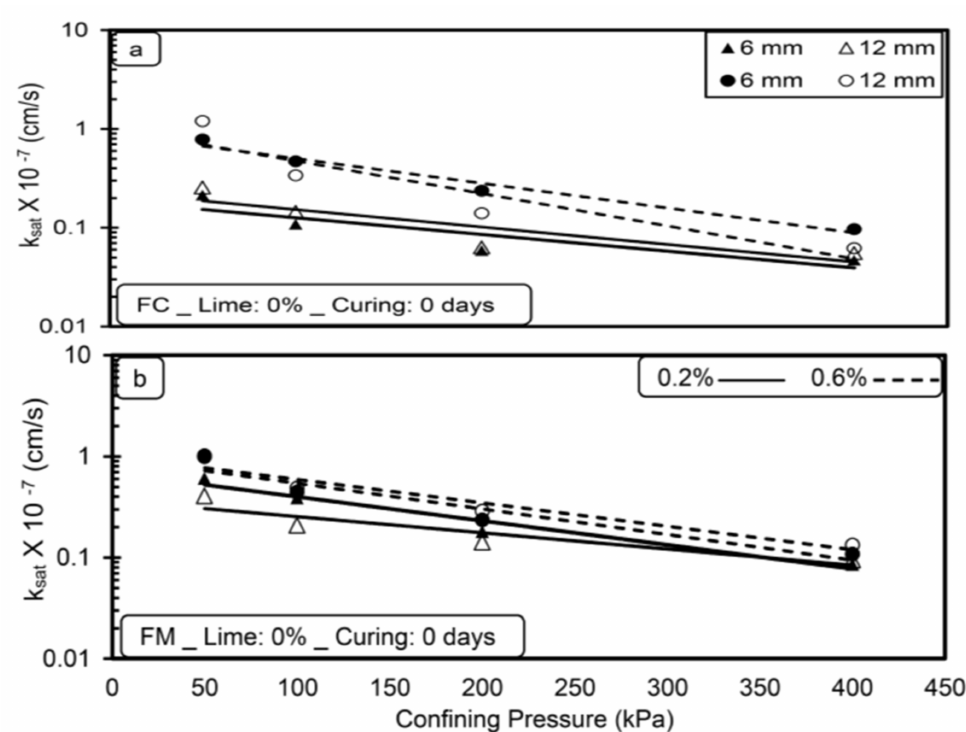
Figure 3. Variations in saturated hydraulic conductivity (k sat ) with confining pressure ( a ) FC ( b ) FM without lime treatment (without curing).